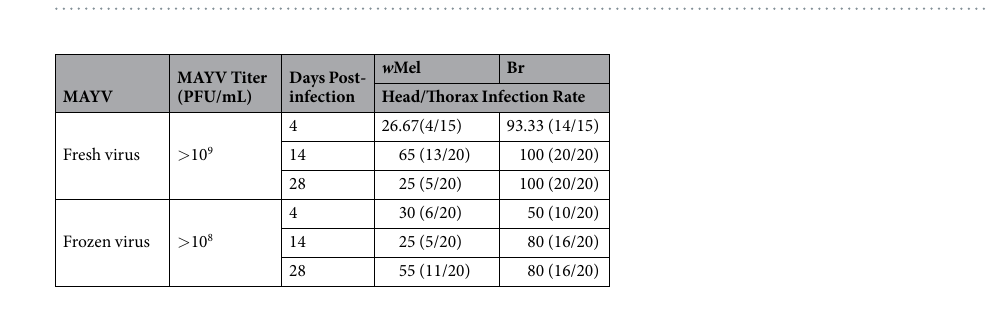
Table 1. Aedes aegypti were orally infected with fresh and frozen MAYV. Infection rates are given as percentages. n = 15 or 20 per group unless specified; PFU, plaque-forming units; w Mel: Wolbachia -infected; Br: Wolbachia